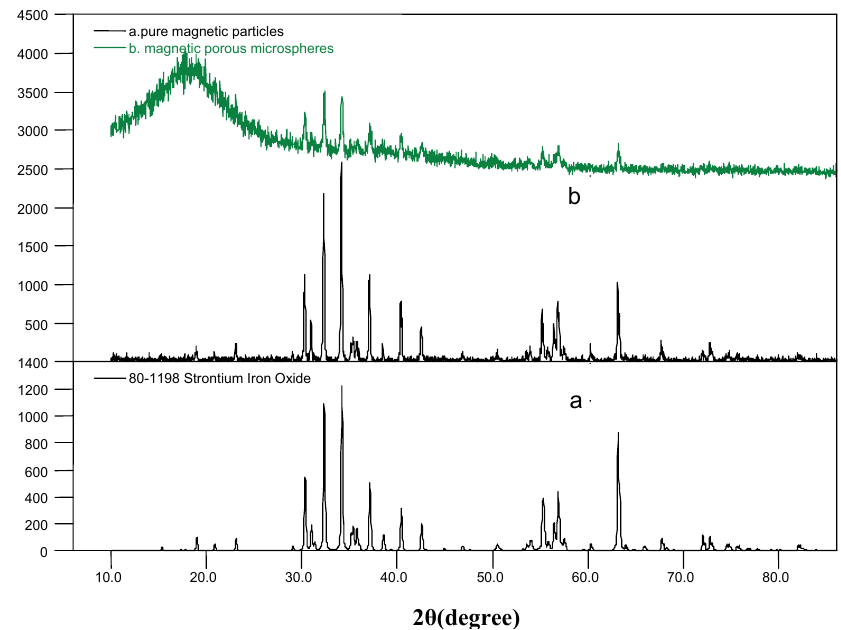
Figure 4. XRD patterns of pure magnetic particles (a) and magnetic porous microspheres